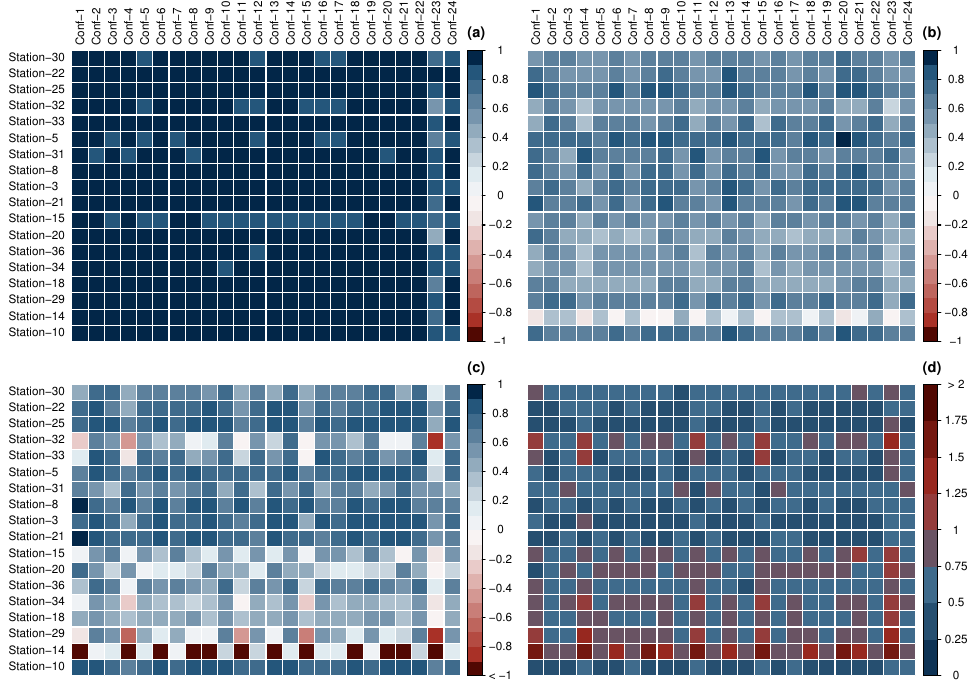
Figure 5. Matrix of statistics for mean temperature: ( a ) correlation, ( b ) KGE, ( c ) NSE, and ( d ) RSR.